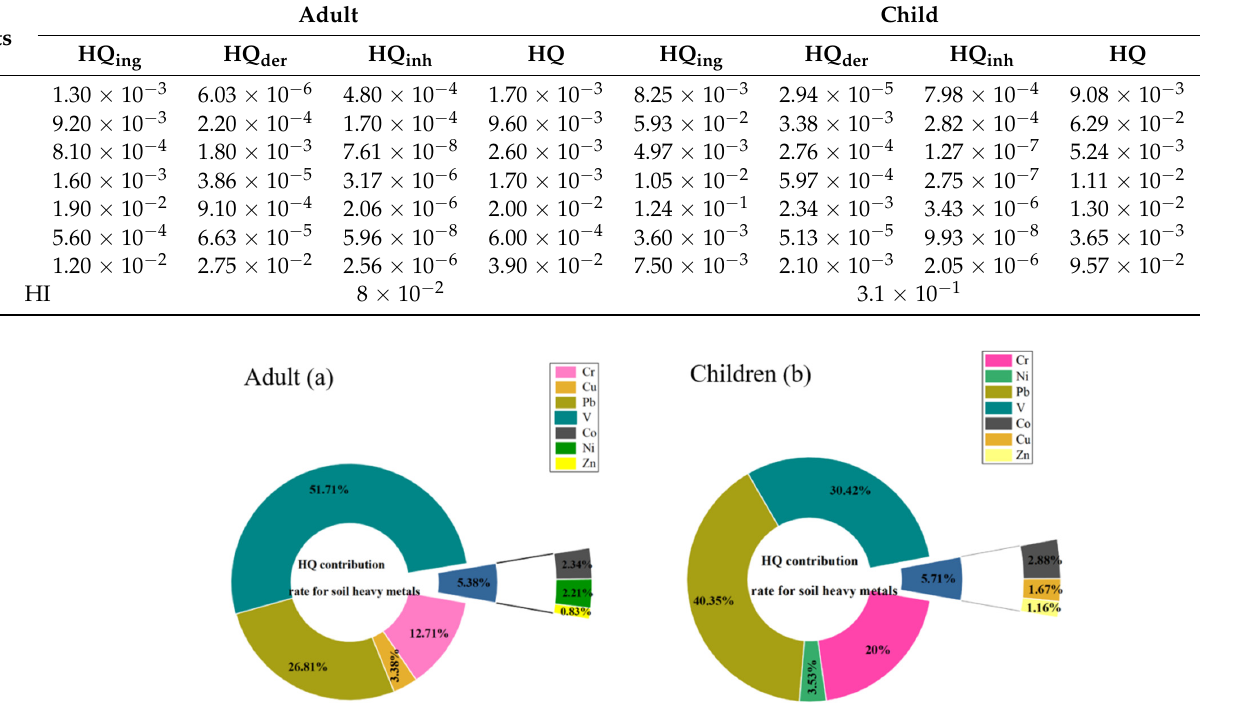
Figure 7. Contribution of different potentially toxic elements to non ‐ carcinogenic risk.